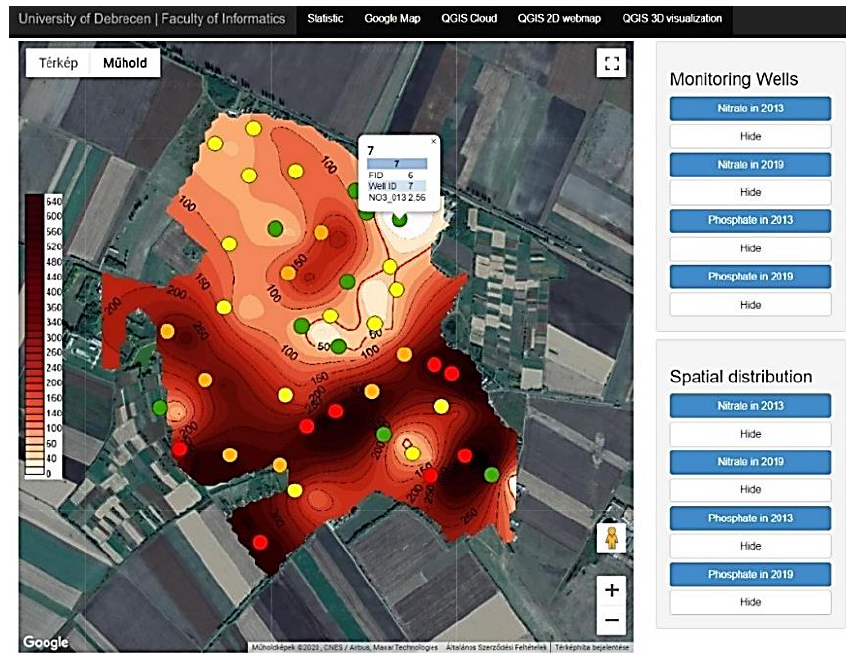
Figure 6. Mash-up webmaps.